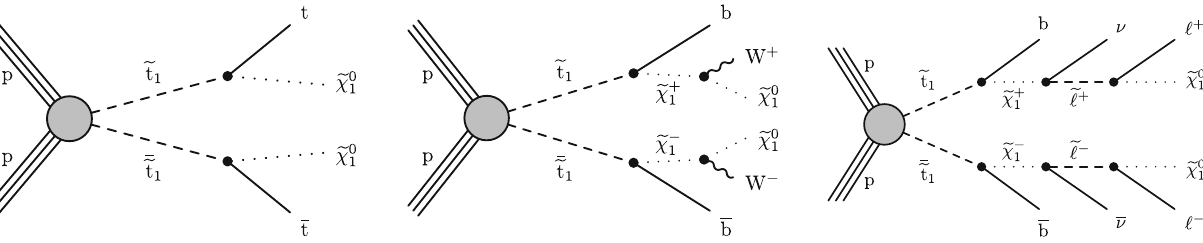
Fig. 1 Diagrams for simplified SUSY models with strong production (cid:2) ˜ t 11 . In the T2tt model (left), the top squark decays of top squark pairs ˜ t 1 to a top quark and a ˜ χ 0 . In the T2bW model (center), the top squark 1 decays into a bottom quark and an intermediate ˜ χ ±